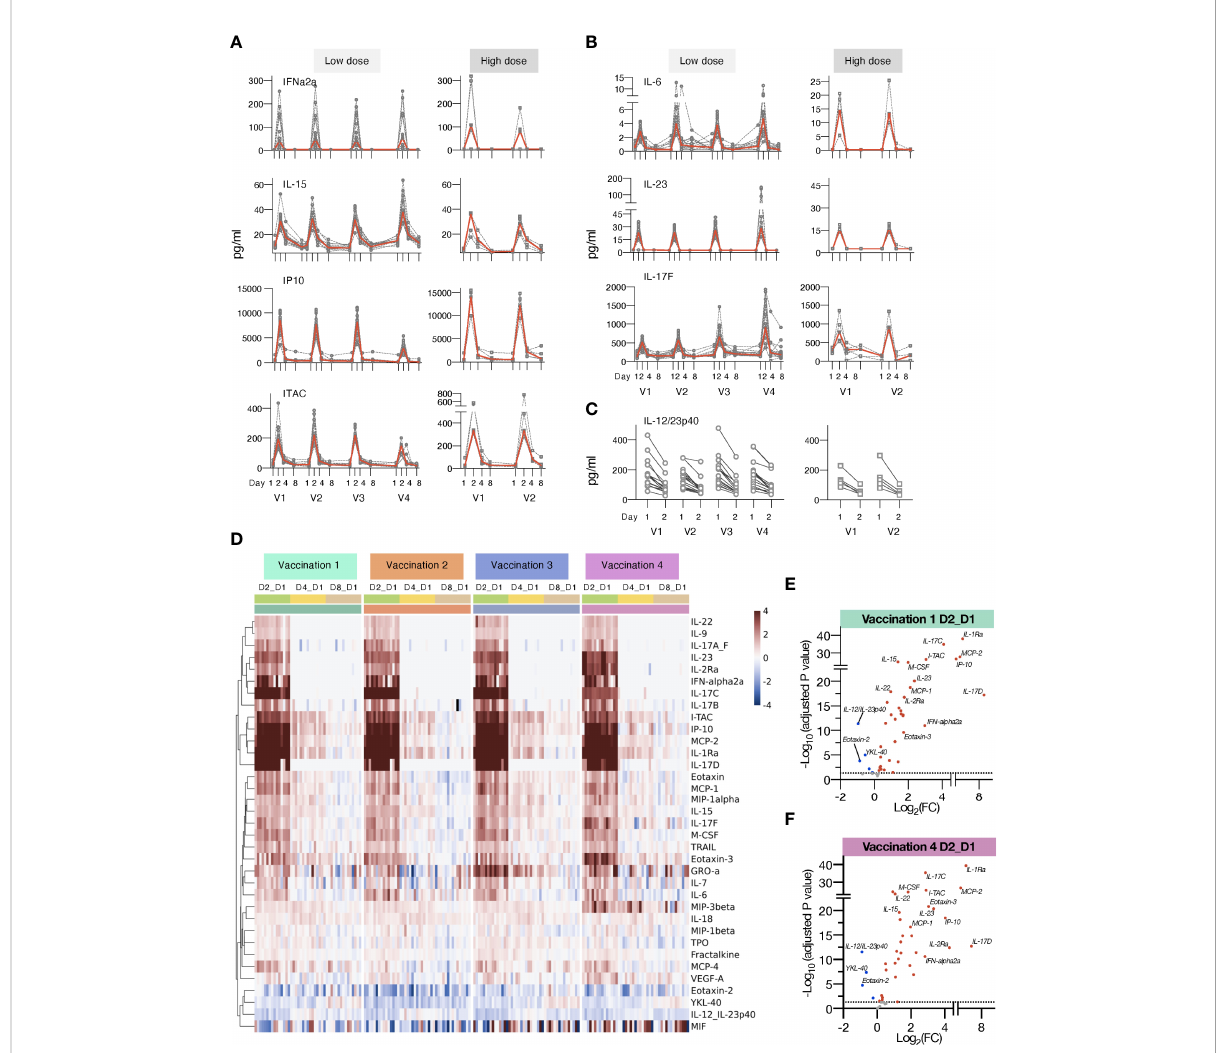
FIGURE 3 Changes in plasma cytokines after vaccination with mRNA/LNPs. Plasma cytokine and chemokine levels were measured using the MSD assay on the day of (D1) and days 2, 4 and 8 (D2, D4, and D8) after each vaccination in macaques receiving mRNA/LNPs vaccine. (A, B) Circulating plasma levels of selected analytes for individual animals (grey lines) and median (red lines) are shown upon the mRNA/LNP vaccinations, administered with low (25 m g, left panels) or high (100 m g, right panels) dose. (A) Molecules involved in IFN pathway, IFN a -2a, IL-15, IP-10/ CXCL10, and ITAC/CXCL11. (B) Molecules involved in the IL-17 pathway, IL-23, IL-6, and IL-17F. (C) Decay in the circulating plasma levels of IL- 12/23p40 between D1 and D2 for the individual animals upon each mRNA/LNP vaccination after receiving low dose (left panel) or high dose (right panel) mRNA/LNP vaccine. (D) Heatmap depicts log2 fold changes (log2 FC) in 35 analytes overtime upon each vaccination (light green: D2_D1; yellow: D4_D1; tan: D8_D1). Cytokine levels at D1 before each vaccination are used as baseline. Comparisons were performed between day1 and day 2 (D2), day 4 (D4) and day 8 (D8), respectively, with data for each animal shown under colored with vaccination 1 to 4 are indicated by the green, orange, blue, and purple bars, respectively. (E, F) Volcano plots of data shown in panel D depict differentially